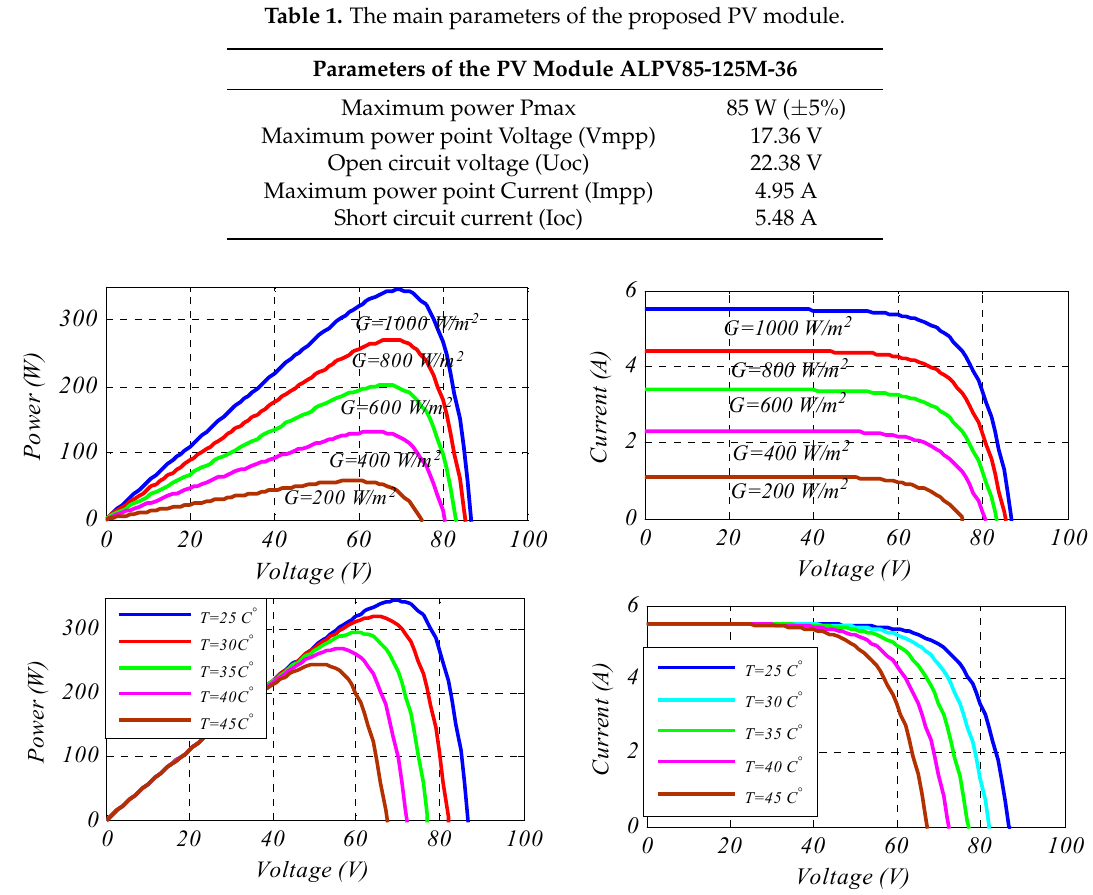
Figure 5. P-V and I-V characteristics of the overall PV system. Table 1. The main parameters of the proposed PV module.